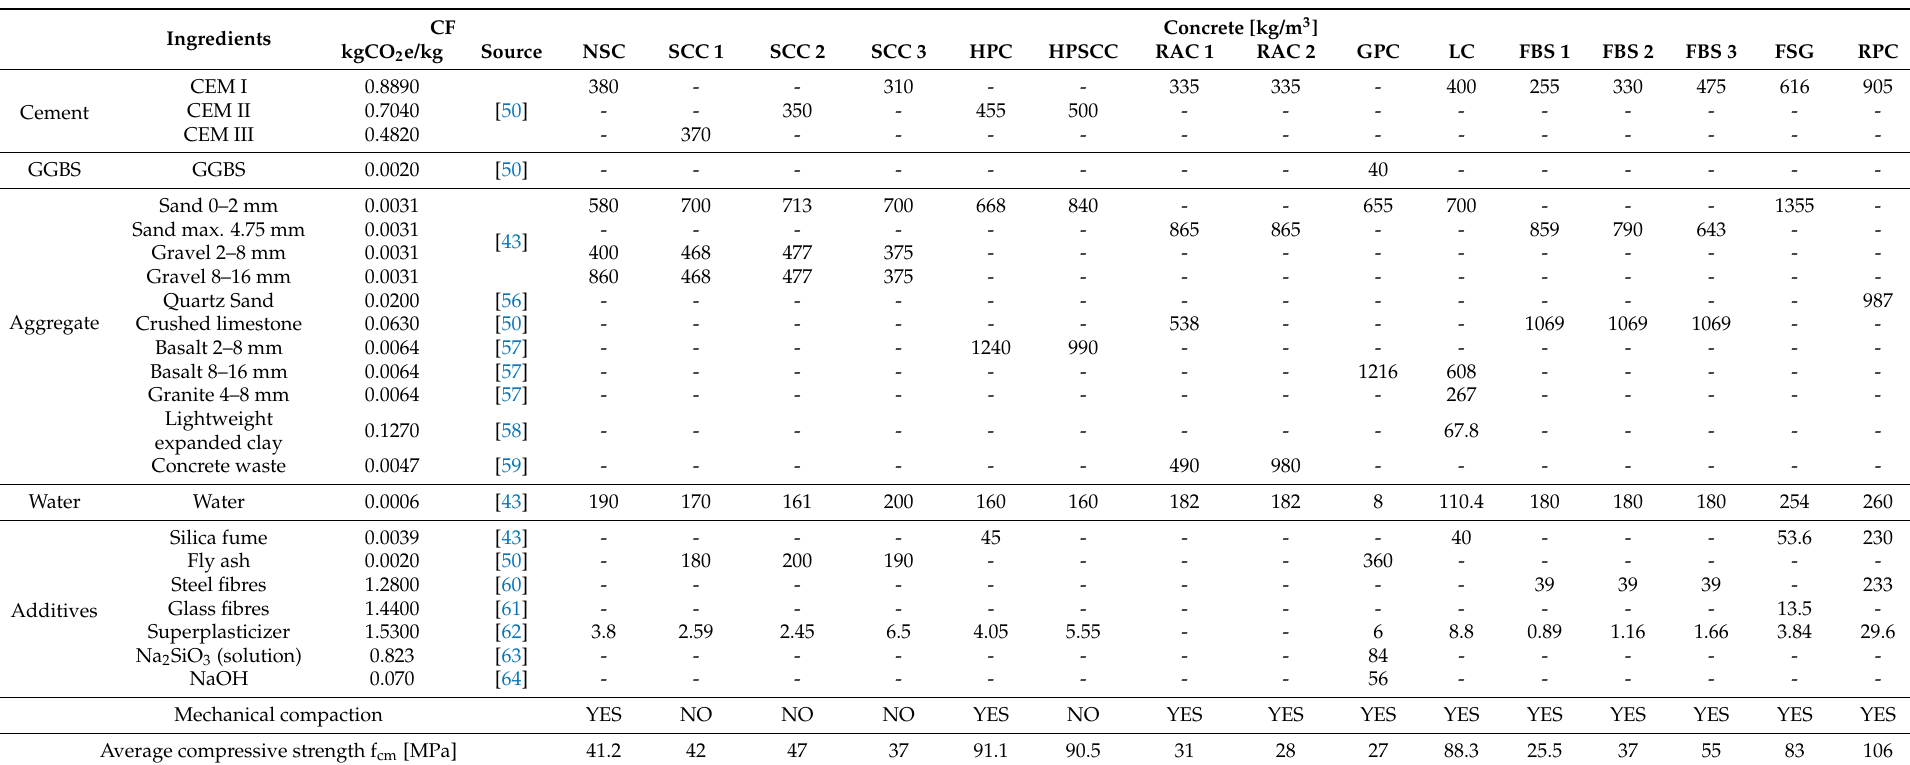
Table 2. Concrete mix compositions used in the